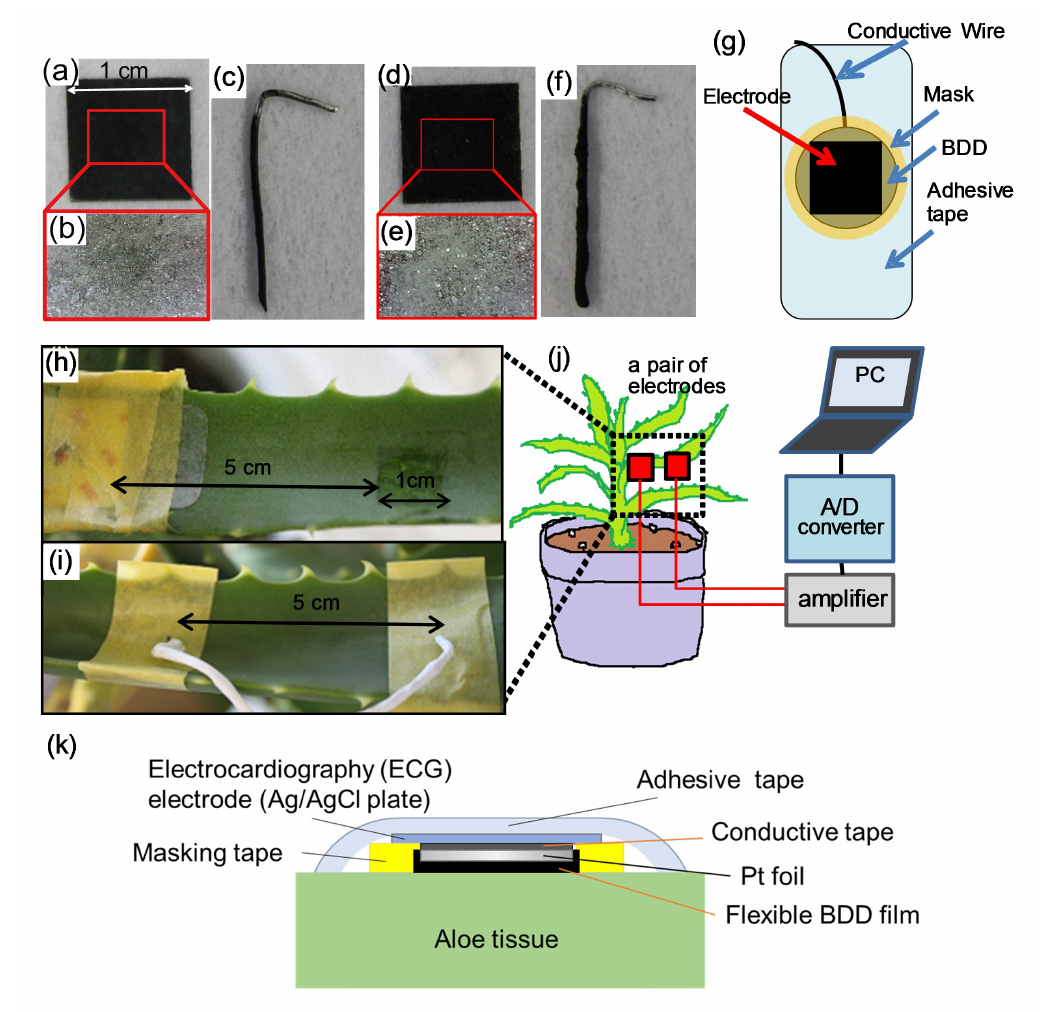
Figure 1. Images of the fabricated electrodes: ( a ) BDD/Nafion film, ( b ) surface of BDD/Nafion film, ( c ) BDD/Nafion needle, ( d ) BDD/Vylon film, ( e ) surface of BDD/Vylon film, surface of BDD/Vylon film, ( f ) BDD/Vylon needle. The structure of the sensor element for the BDD plate- or film-type electrodes is shown in ( g ). Images showing the attachment of the ( h ) BDD plate- or film-type sensor elements and ( i ) needle-type electrodes to the plant. ( j ) Schematic of the measurement system for plant monitoring. ( k ) Schematic cross-section of a film-type electrode installed on an Aloe